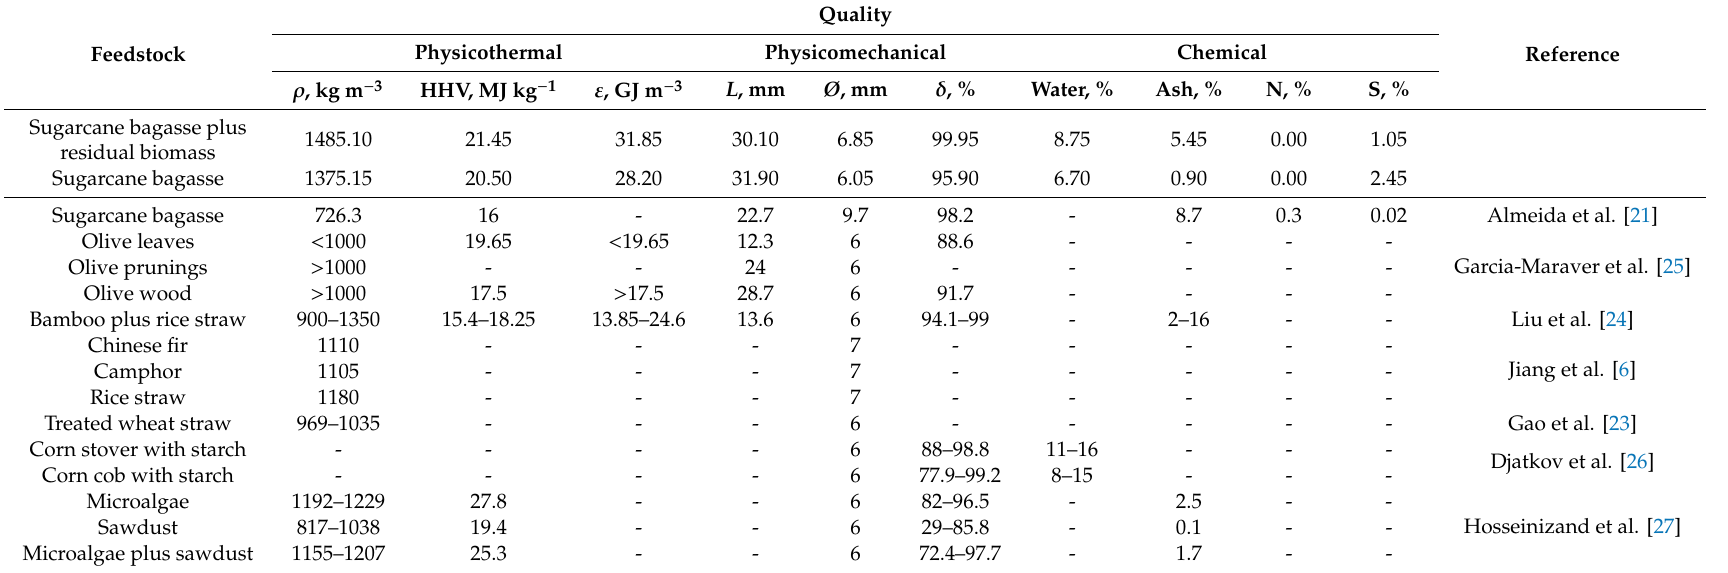
Table 5. Relative quality of hybrid non-wood pellets from pressing sugarcane bagasse with residual biomass from distillation of cellulosic bioethanol.